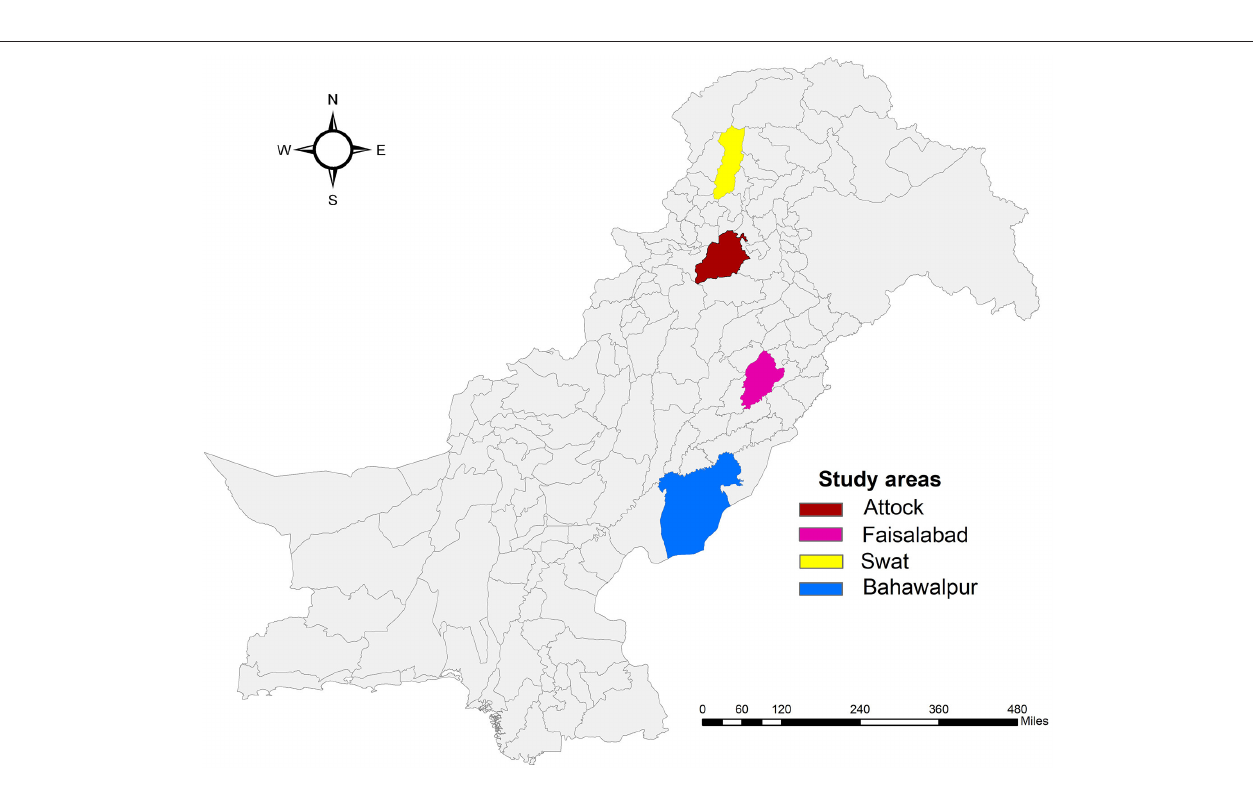
300–400 mm (27). Most of Bahawalpur (28 ◦ 39’ latitude, 70 ◦